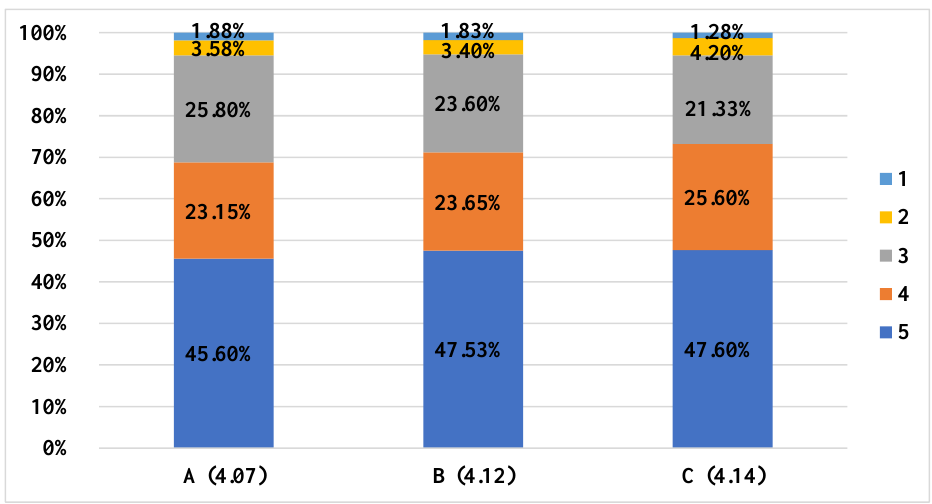
Figure 5. Manual evaluation outcomes for Chinese → Japanese translations.